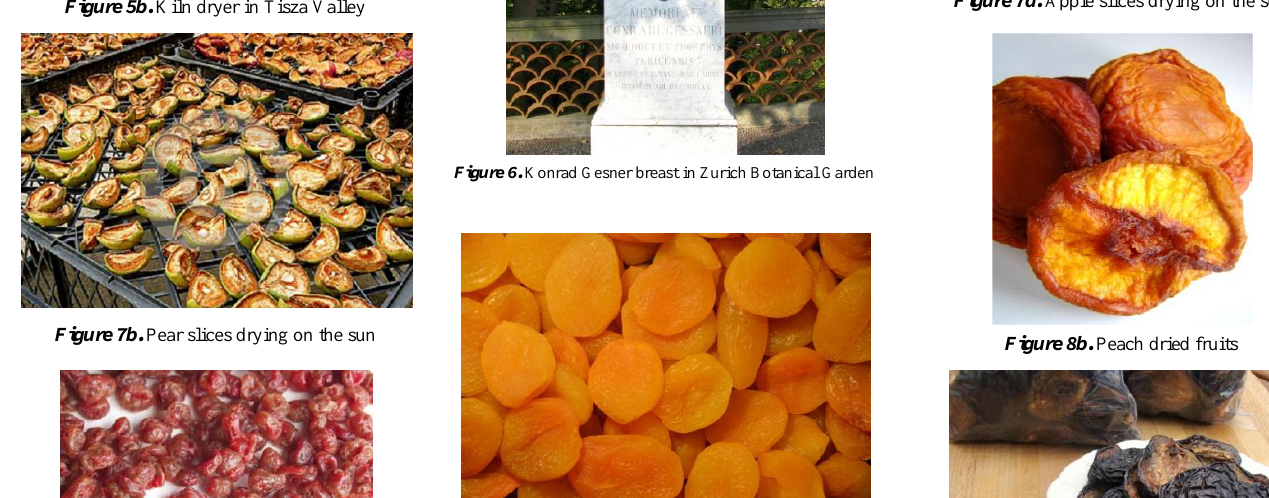
Figure 5b. Kiln dryer in Tisza Valley